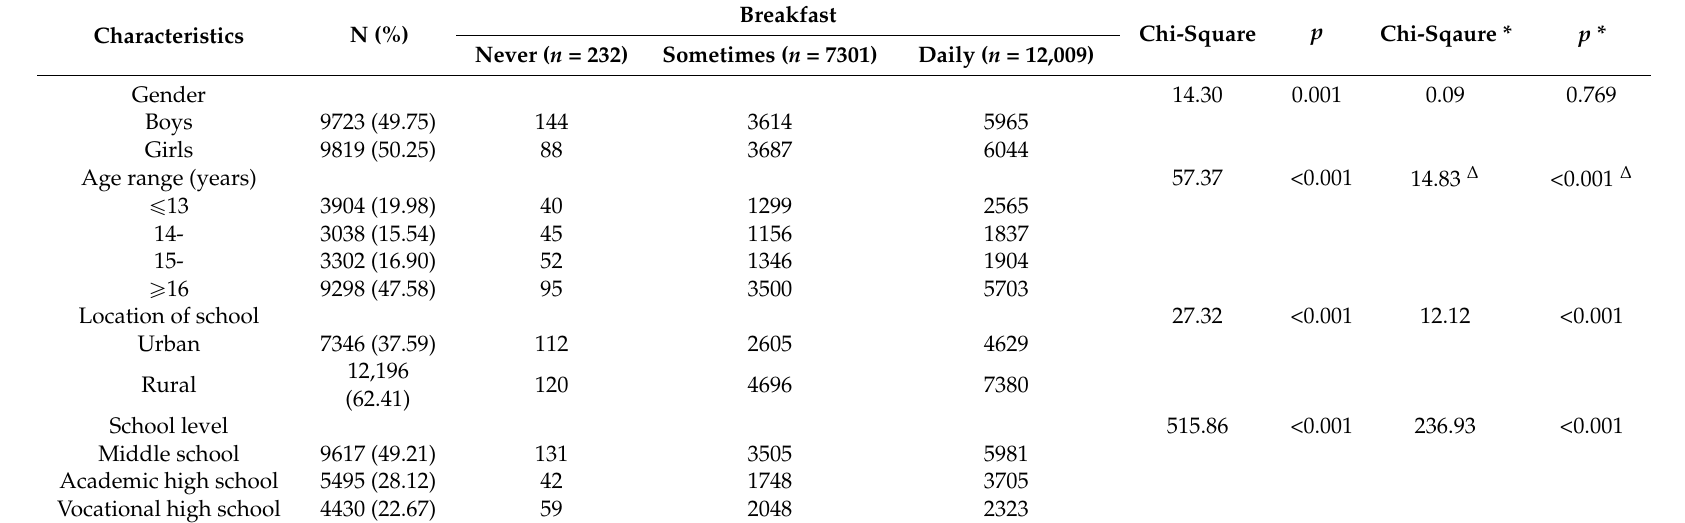
Table 2. Demographic characteristics of students and the associations with breakfast